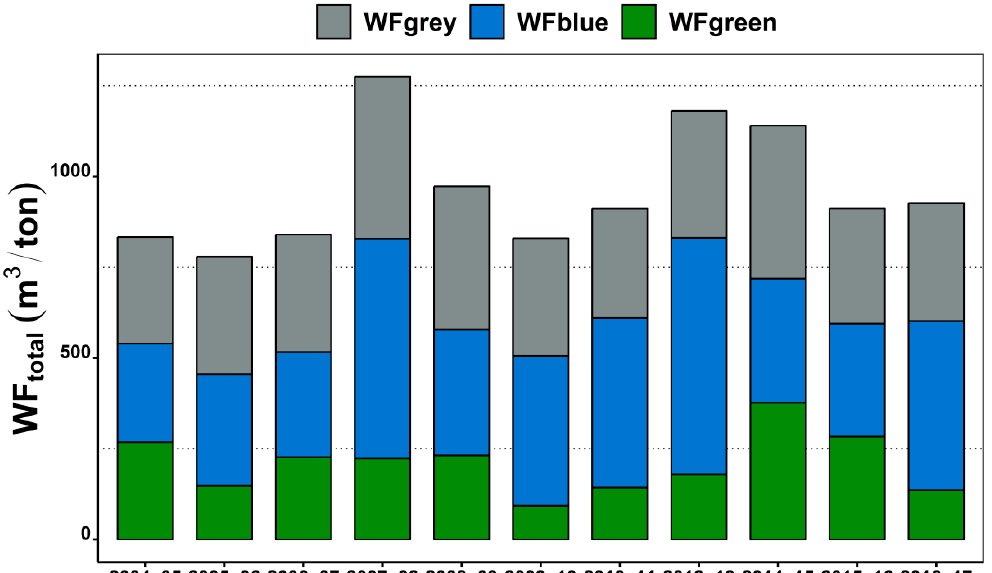
Figure 10. Composition of wheat total water footprints (WF total ) in terms of grey (WF grey ), blue (WF blue ), and green water footprints (WF green ) from 2004–2017.